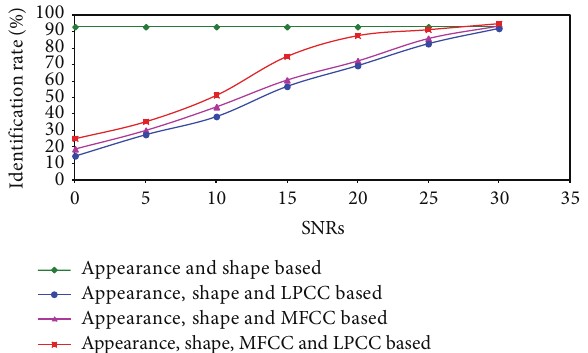
Figure 4: Result of various combinations of audio features with appearance based facial feature.